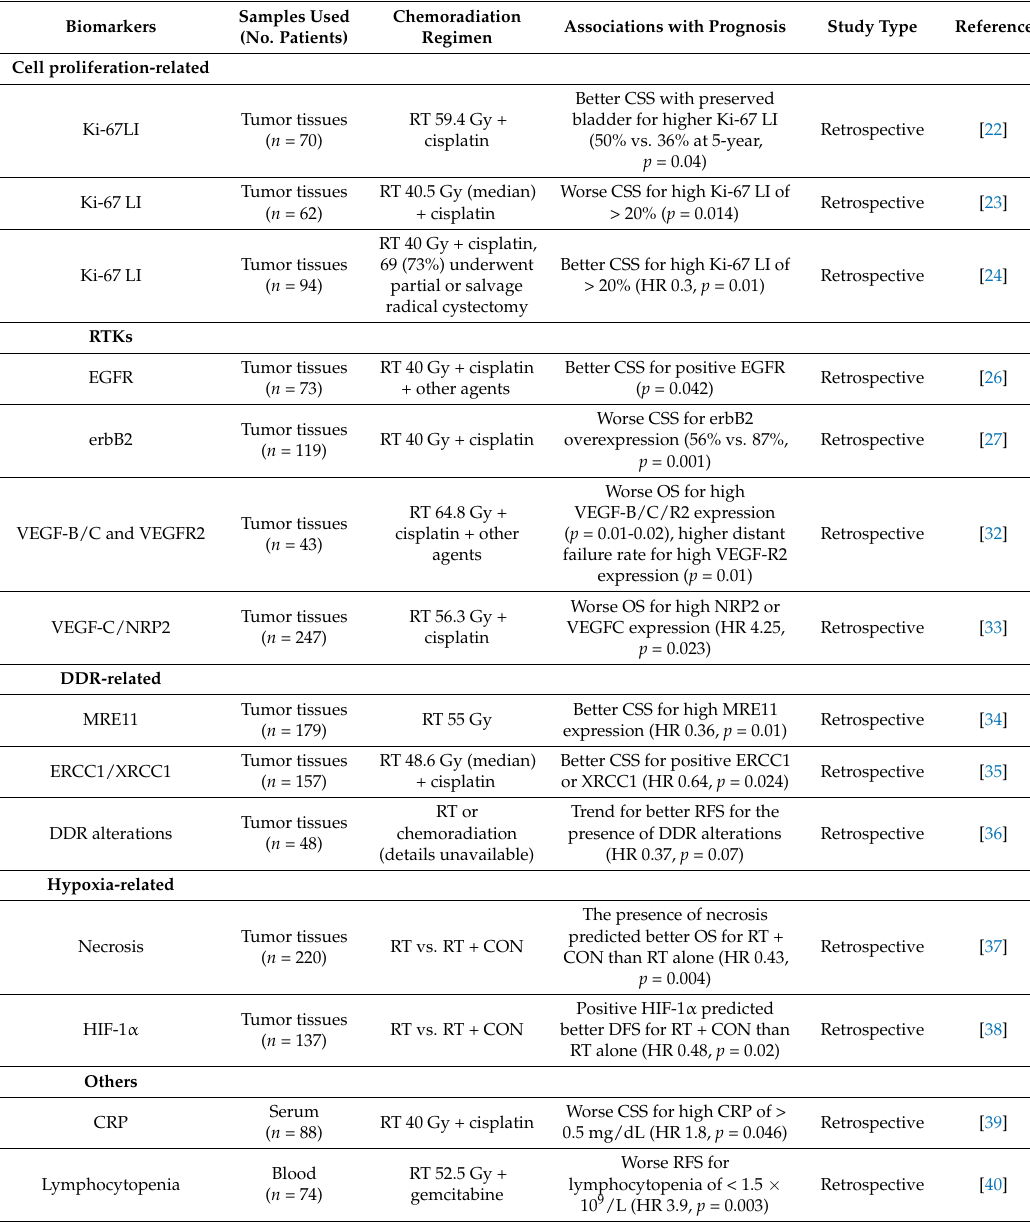
Table 2. Biomarkers associated with prognosis of muscle invasive bladder cancer patients on chemoradiation-based bladder preservation